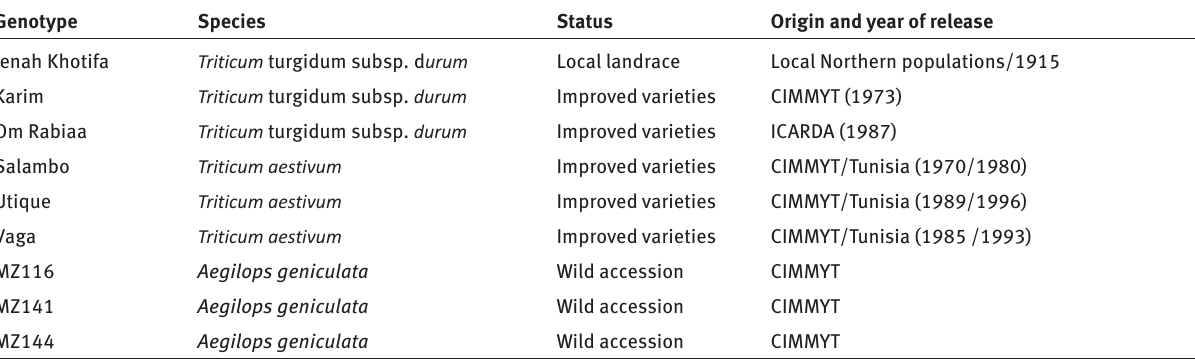
Table 1: List of the studied wheat varieties and accessions along with their characteristics